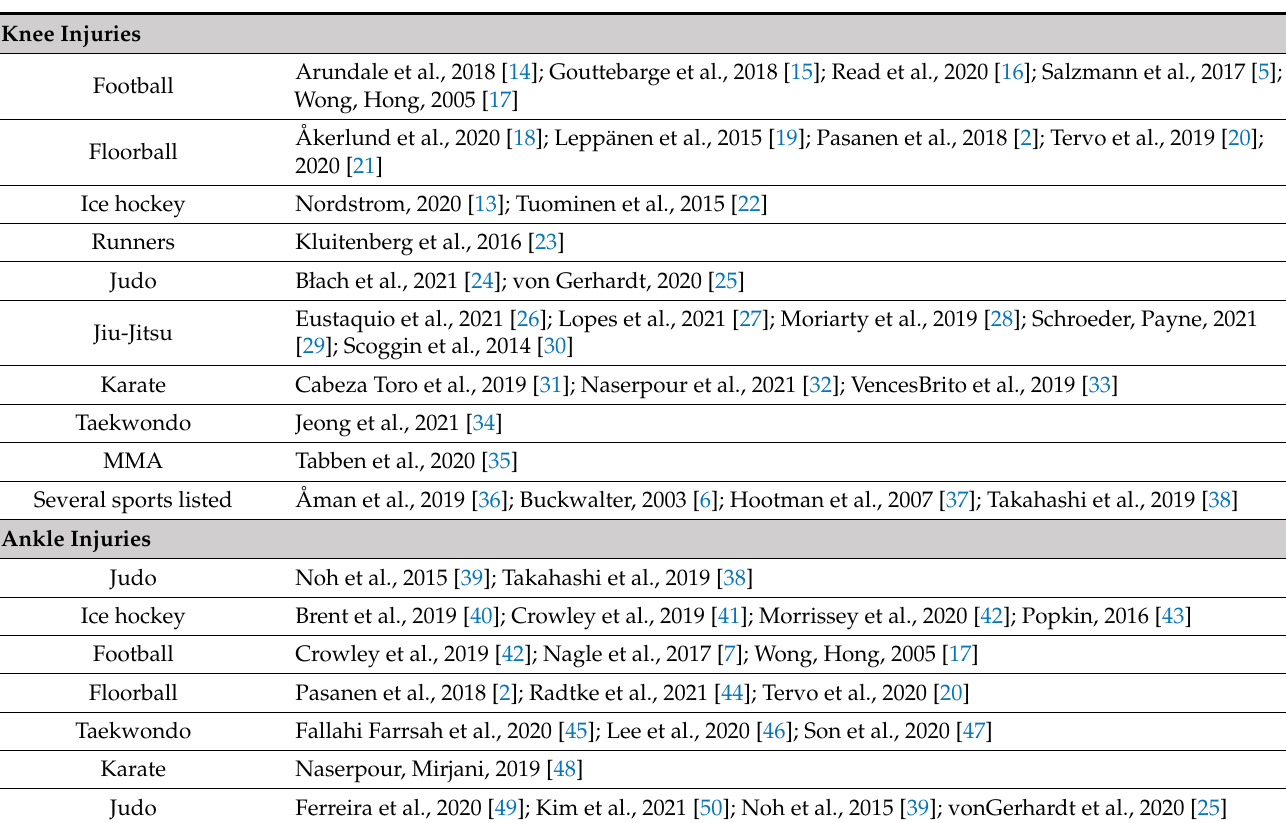
Table 1. Authors citing the knee and ankle injuries as one of the most